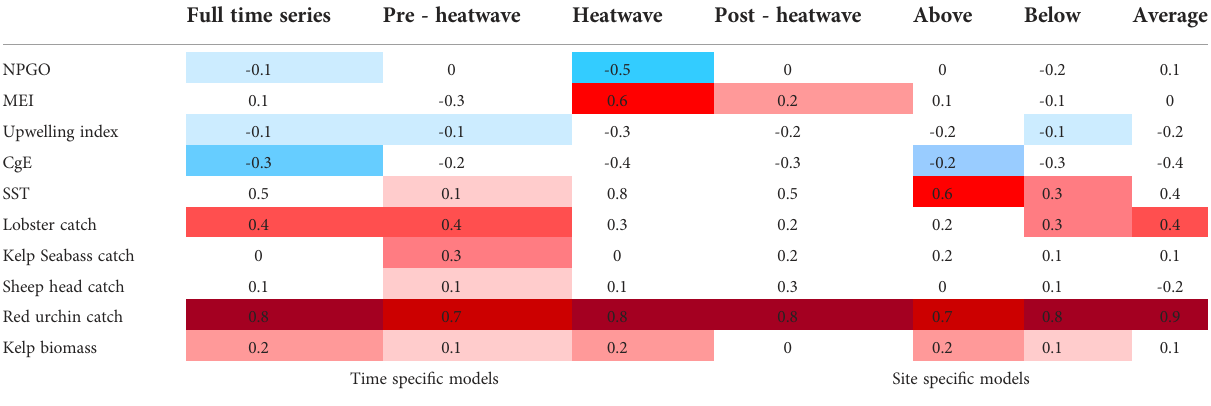
The intense color indicates variables that were more signi fi cant (red, positive, and blue, negative), and pale colors indicate less signi fi cant variables. Variables without color were not signi fi